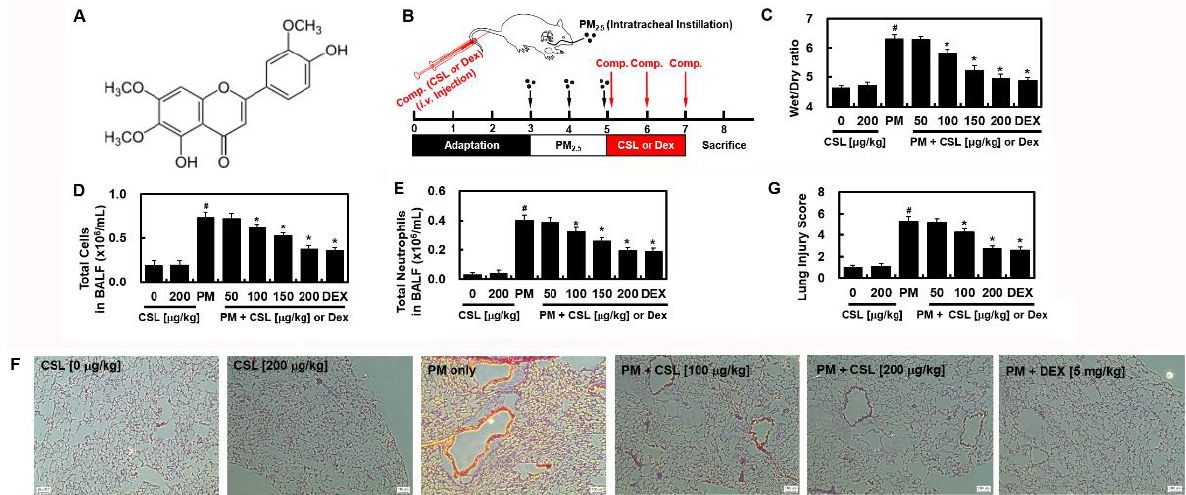
Figure 1. Effects of cirsilineol (CSL) on PM 2.5 -induced lung toxicity. ( A ) Chemical structure of cirsilineol (CSL). ( B ) Schematic illustration of in vivo PM 2.5 -induced lung toxicity experiment protocol. Two days after PM 2.5 exposure (10 mg/kg in 50 µ L saline) daily by intratracheal instillation, the mice were intravenously injected with CSL or dexamethasone (DEX) daily for three consecutive days. The control and PM2.5 groups received an equal amount of vehicle [0.5% dimethyl sulfoxide